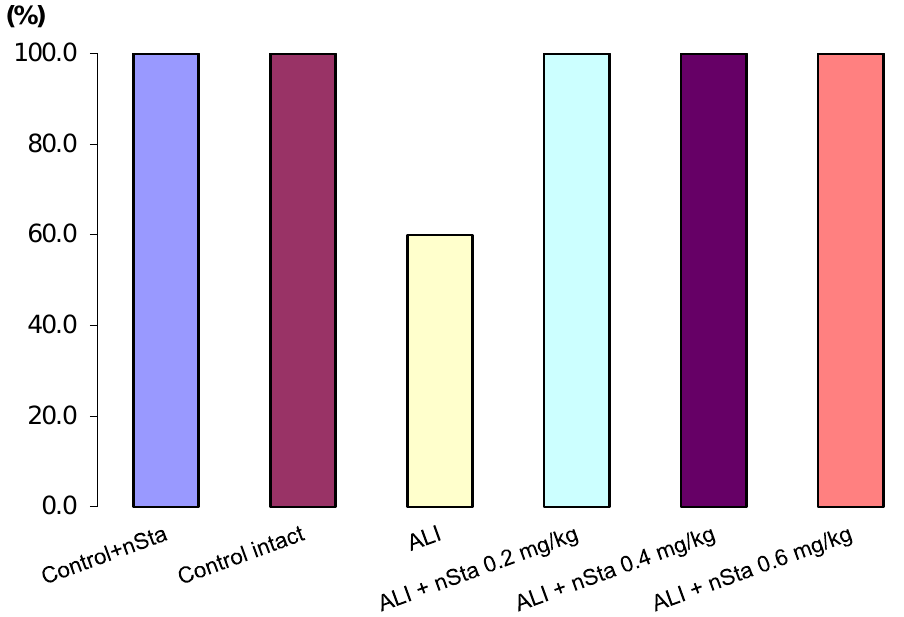
Figure 1. Survival analysis of Control + nSta, Control intact, untreated lipopolysaccharide (LPS)- induced acute lung injury (ALI) mice, and LPS-induced ALI mice receiving nSta 0.2 mg/kg, nSta 0.4 mg/kg, or nSta 0.6 mg/kg for up to 8 days after LPS administration ( n = 10 for each group at the beginning of the experiment).